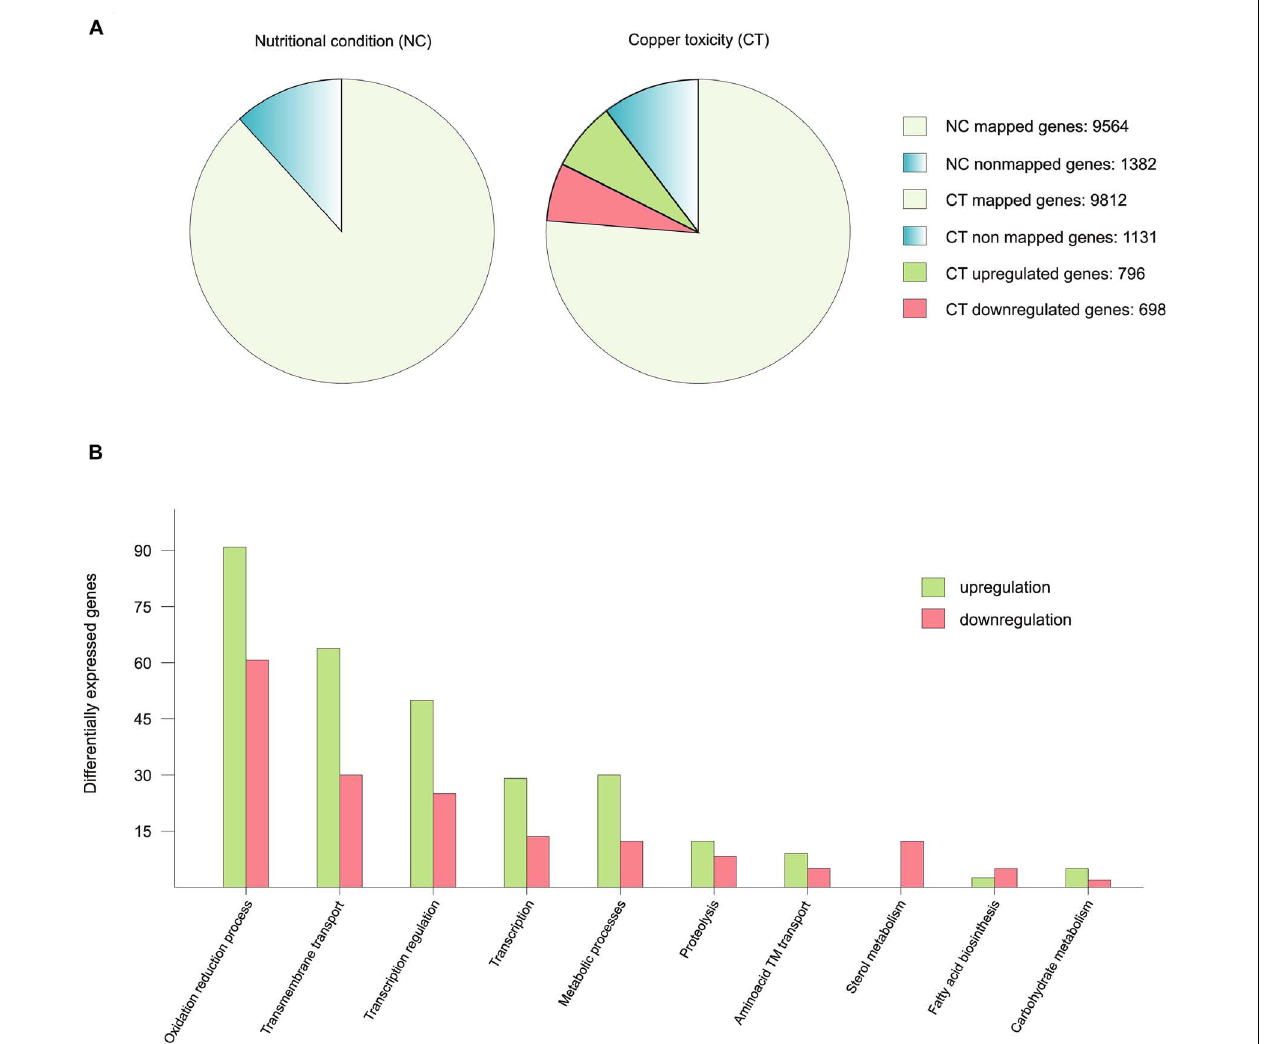
FIGURE 1 | Graphic representation of the RNA-seq results. (A) To exemplify the number of mapped genes in each condition, the 10.943 genes predicted by the AspGD were considered as 100% and data was presented in percentages. The differentially expressed genes are represented in the copper toxicity pie chart divided in two colors in proportion to the number of up-regulated and down-regulated genes. (B) Representation of the up-regulated and down-regulated genes of the most affected biological processes.